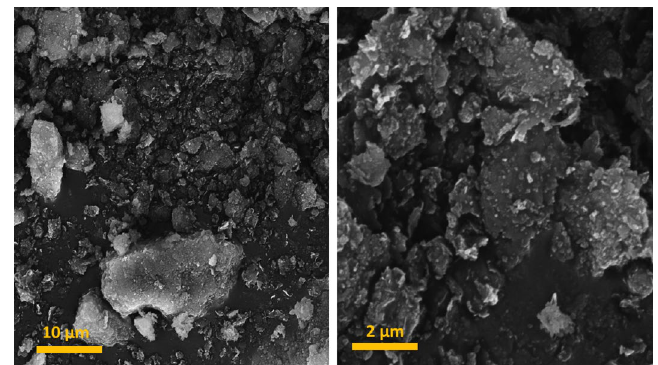
Figure 5. SEM images of the